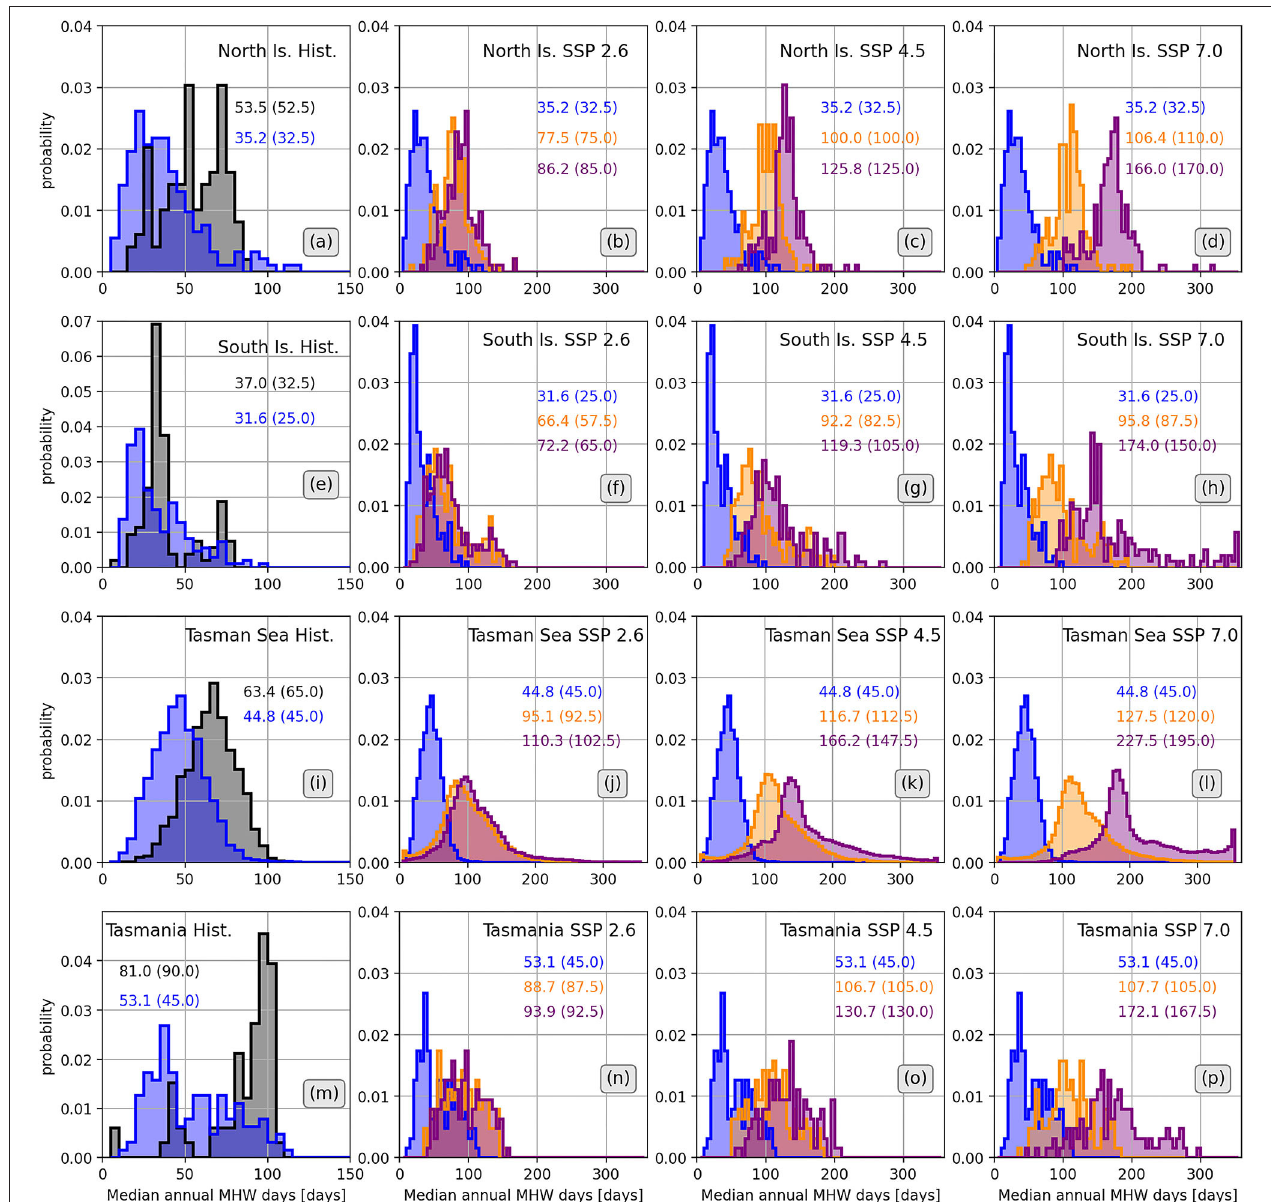
FIGURE 4 | Evolution of annual MHW days. Histograms show the probability distribution for certain regions, and periods for the historical simulations and future projections. (a–d) coastal region around the North Island. (e–h) coastal region around the South Island. (i–l) over the Tasman Sea and (m–p) around Tasmania. Regions are shown in Figures 1 , 2 and Supplementary Figure S4 . NOAA OI-SST is represented by black, while NZESM is represented by blue for the historical period 1995–2014. For the future scenarios the orange and purple distribution indicates 2040–2059 and 2080–2099, respectively. The color coded numbers in each panel represent the mean (median, in parenthesis) annual MHW days for each distribution. The annual MHW days bins are 5 days wide and the area under curve integrates to 1. The model data represents results of a 60 year member ensemble i.e., 20 years of data from each of the three-ensemble